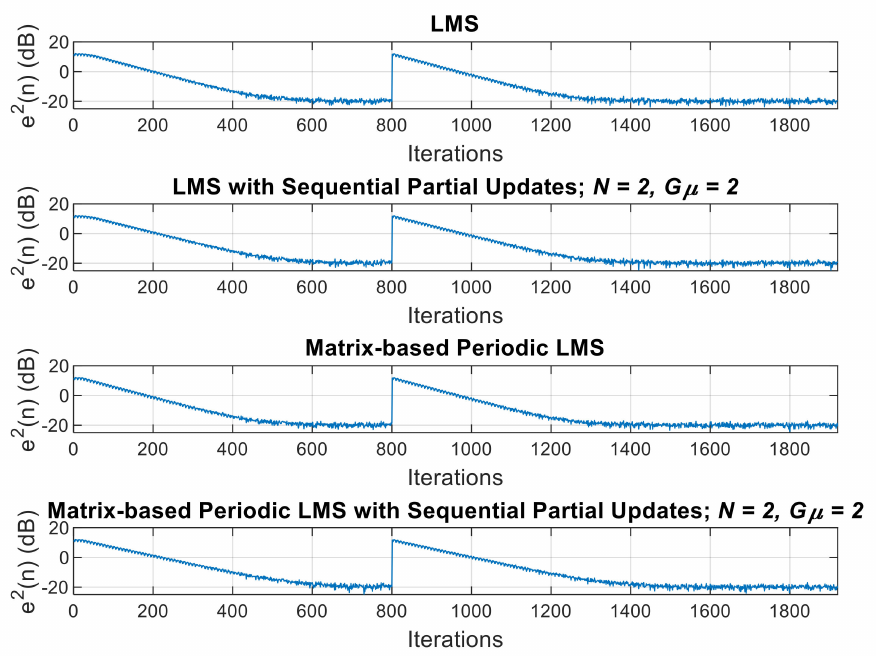
Figure 14. Learning curves comparison. Version 2 of the experiment: desired signal d 2 ( n ) and reference signal x 2 ( n ) . ( a ) LMS, ( b ) LMS with Seq PU; N = 2 and G µ = 2, ( c ) P-LMS, ( d ) P-LMS with Seq. PU; N = 2 and G µ = 2. Average of 50 runs. The performance measure used is the instantaneous squared error in logarithmic scale